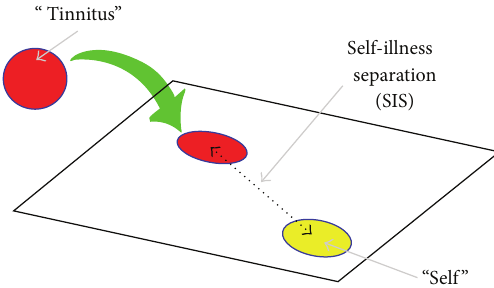
Figure 1: Self-evaluation of individual tinnitus-related distress by means of PRISM. TI imagined a metal board representing her life and a small yellow circle on the board representing her self. The task was to place a small magnetic red disk on the board to indicate the current salience and distress of tinnitus in the patient’s life. Afterwards, the distance between the self and the tinnitus disk